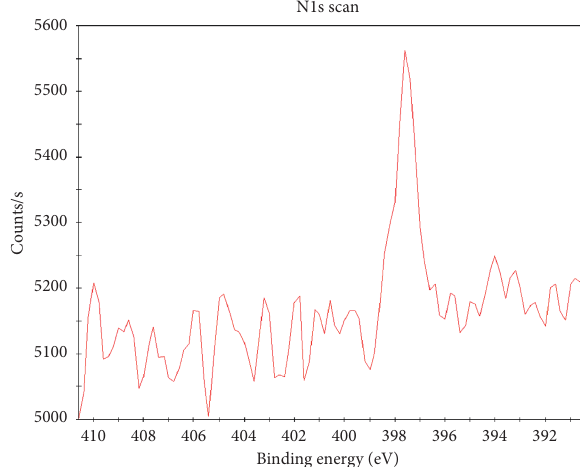
Figure 4: XPS N1s spectrum from surface of silicon coupon milled with N + at 5 kV.